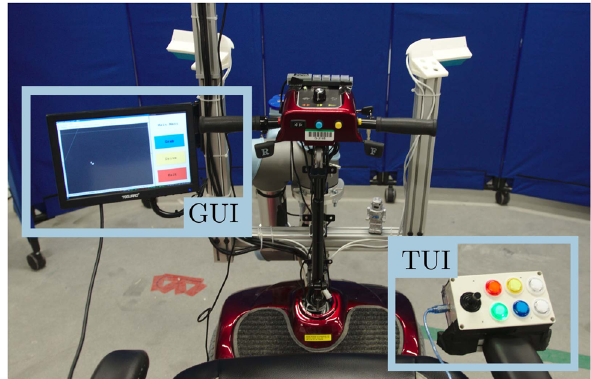
Figure 4: First person point of view from the assistive robot system showing the touchscreen for control of the GUI, and button panel for control of the